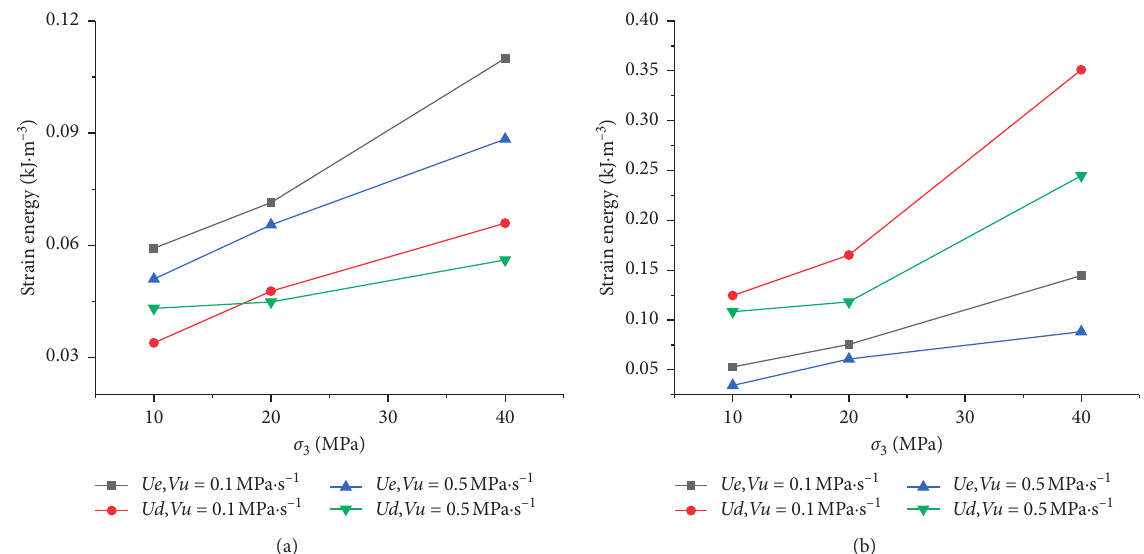
Figure 13: Strain energy eigenvalue curves of the unloading test at peak strength: (a) unloading triaxial test; (b) unloading confining-loading axial pressure test.